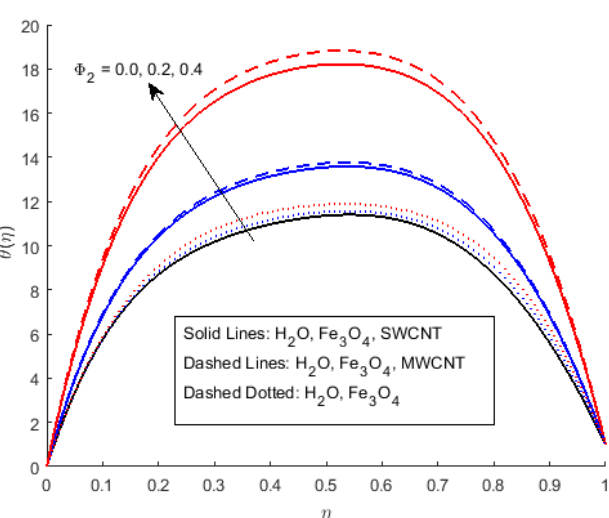
Figure 8. Effect of θ ( η ) for Φ 2 and fixed values of S = 0.5, Re m = 2.5, Ha = 0.4, Pr = 6.2, Ec =